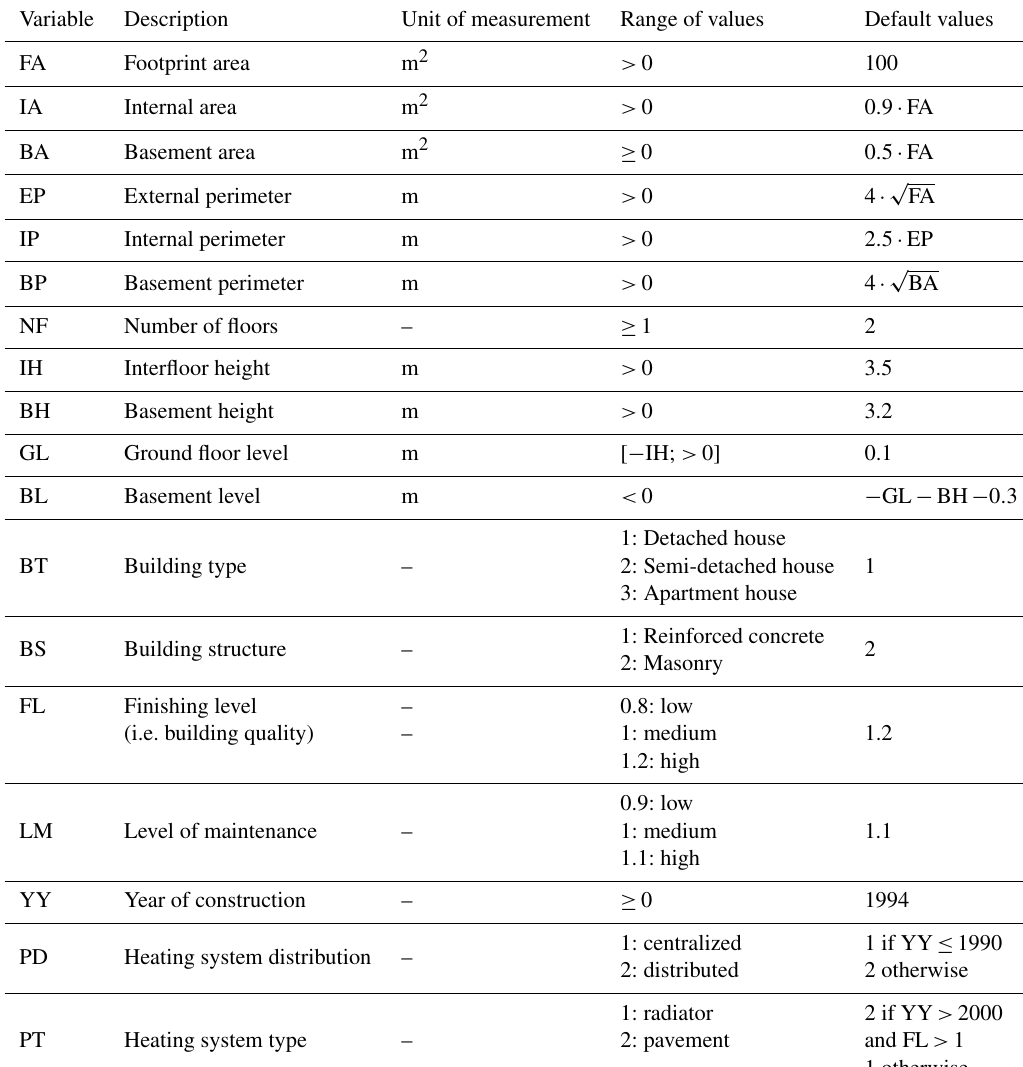
Table 3. Building characteristics parameters considered in